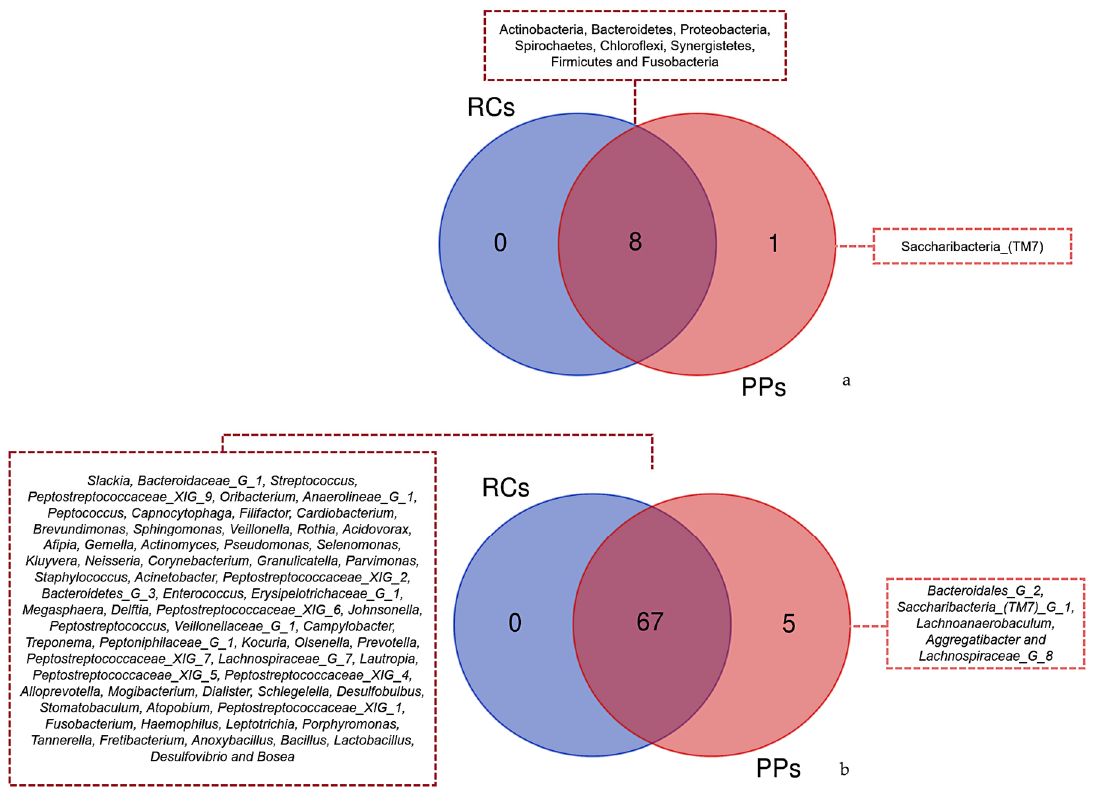
Figure 5. Venn diagram showing overlap of the identified reads for ( a ) Phyla between the different samples root canals (RCs) and periodontal pockets (PPs). Overlapping of ( b ) Genus with the highest number of readings identified between different samples Root Canals (RCs) and Periodontal Pockets